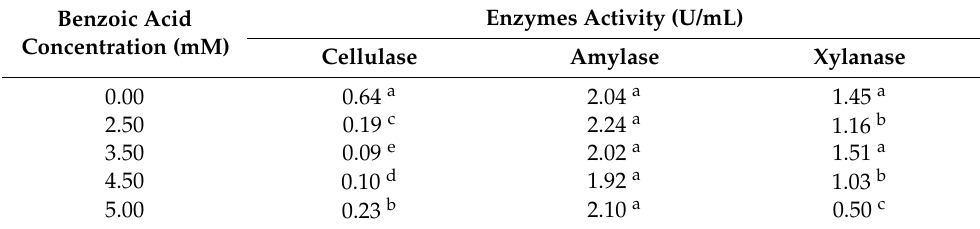
Table 3. Production of hydrolytic enzymes by G. boninense under the influence of benzoic acid. Benzoic Acid Concentration